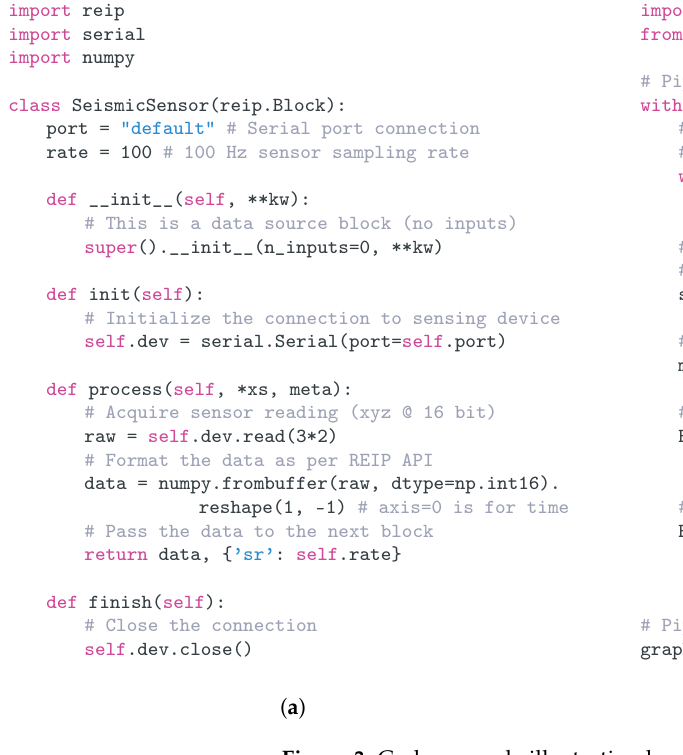
Figure 3. Code example illustrating how to extend REIP SDK to work with new sensing